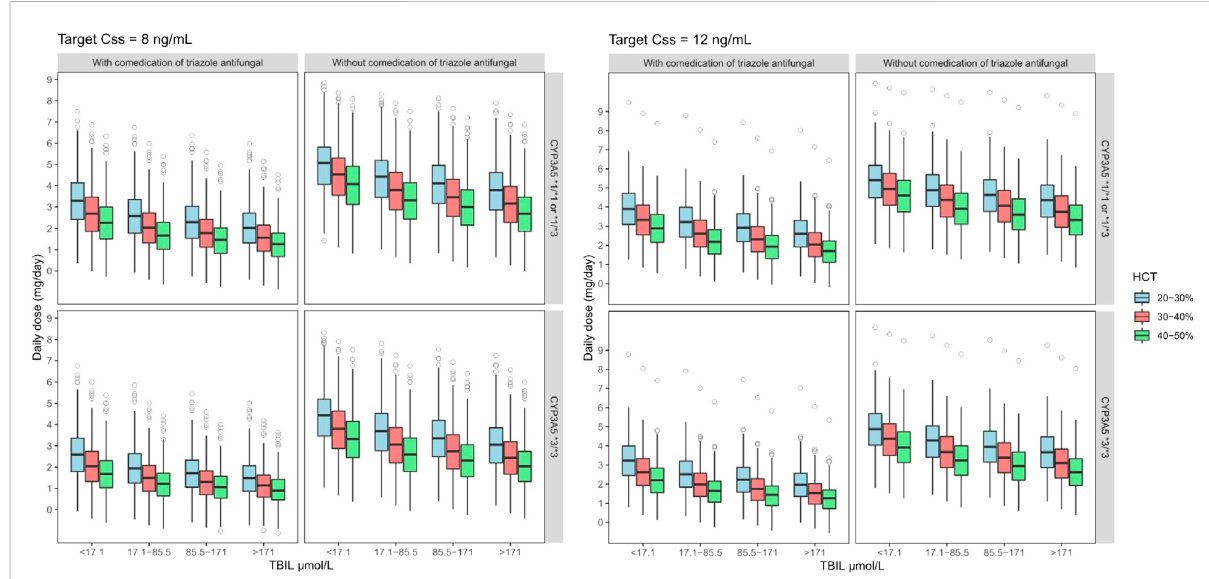
FIGURE 5 Boxplotsofthedistributionsofsimulatedtacrolimusdailydosefor CYP3A5*1*1or*1*3 and *3*3 ontargetsteady-statetroughconcentrationsat 8 – 12 ng ml − 1 for co-administered with triazole antifungal group in different TBIL and HCT levels. The bold horizontal bars in the middle show the median values, whereas the outer boundaries of the boxes represent the ranges of the 25th and 75th percentiles (interquartile ranges). The whiskers indicate the maximum and the minimum values of daily dose. Dots represent the